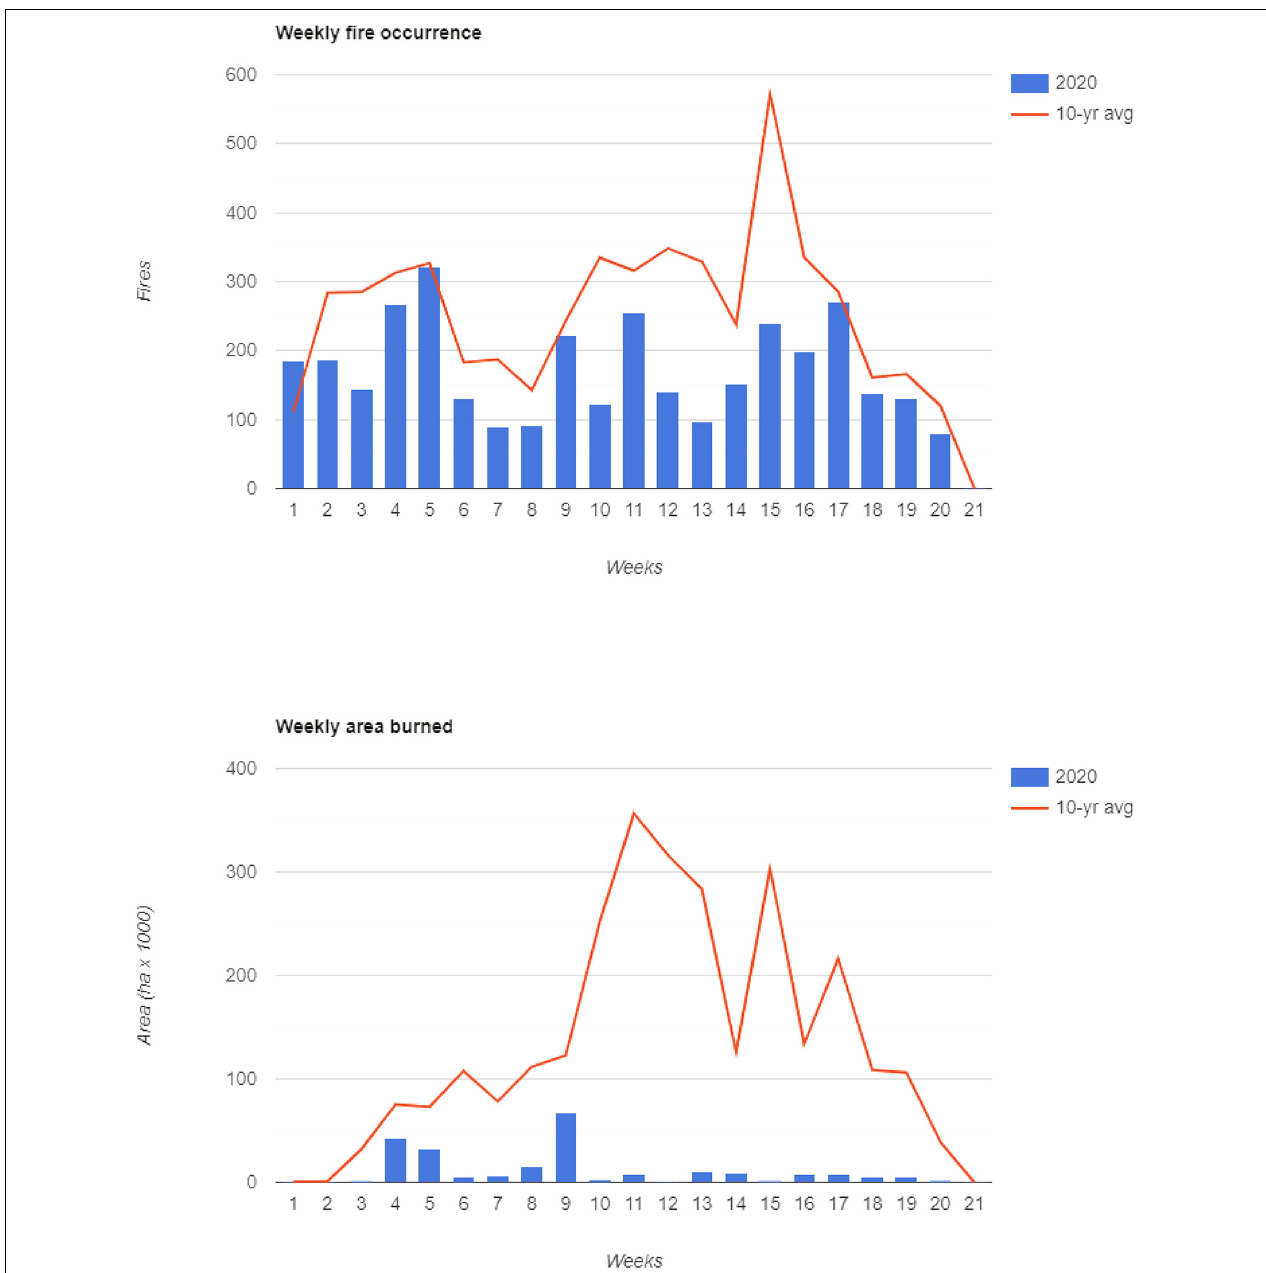
FIGURE 2 | 2020 fire season in Canada was below the 10-year average both in terms of number of fires and area burned (Source: NRCan, 2020b).